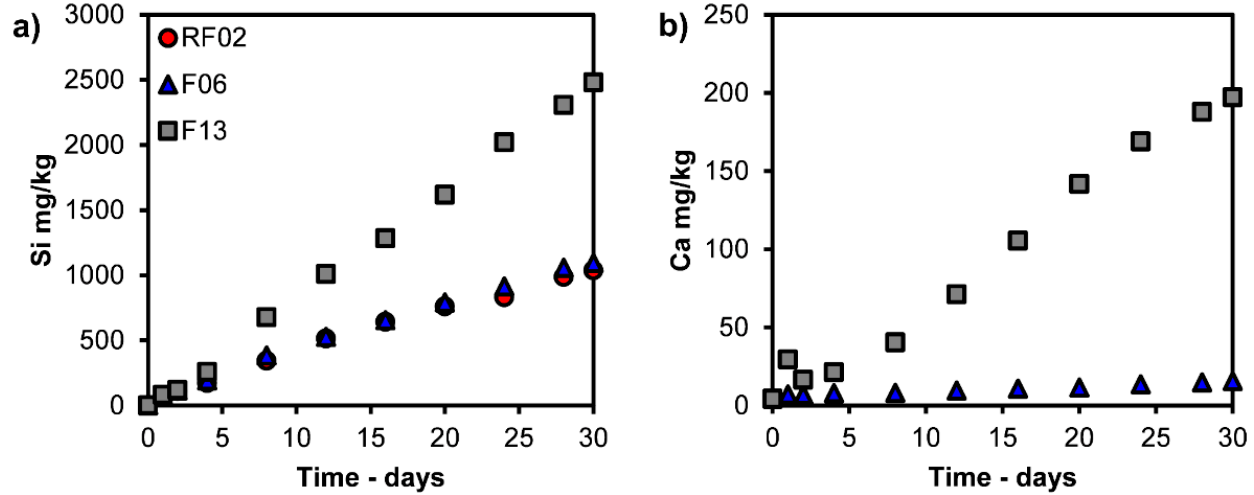
Figure 4. Leaching values of ( a ) Si and ( b ) Ca (mg/kg) versus time from dynamic leaching tests; Ca was not determined for RF02.